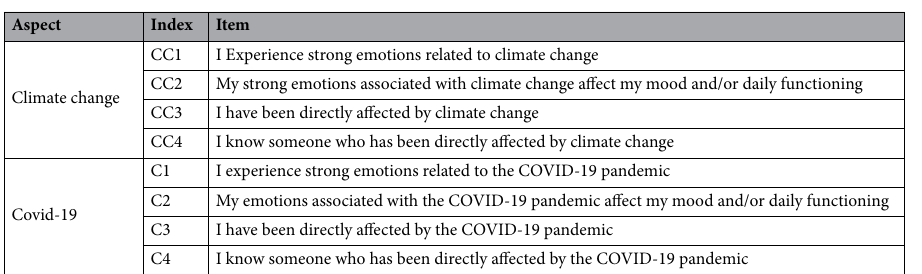
Table 1. Questions related to climate change and Covid-19 pandemic used in the study. Each question was rated on a Likert scale from 1 (I strongly disagree) to 5 (I strongly agree).